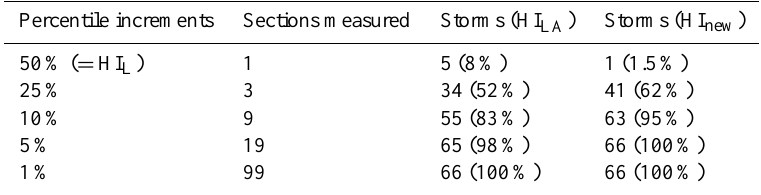
Table 1. Showing the increments of discharge measured and the corresponding number of storms (out of 66 analysed) and the percentage of storms which can be robustly ∗ characterised using different HI methods. ( ∗ Where adding extra measurement sections does not statistically change the distribution of HI vales for a storm.) Percentile increments Sections measured Storms (HI LA